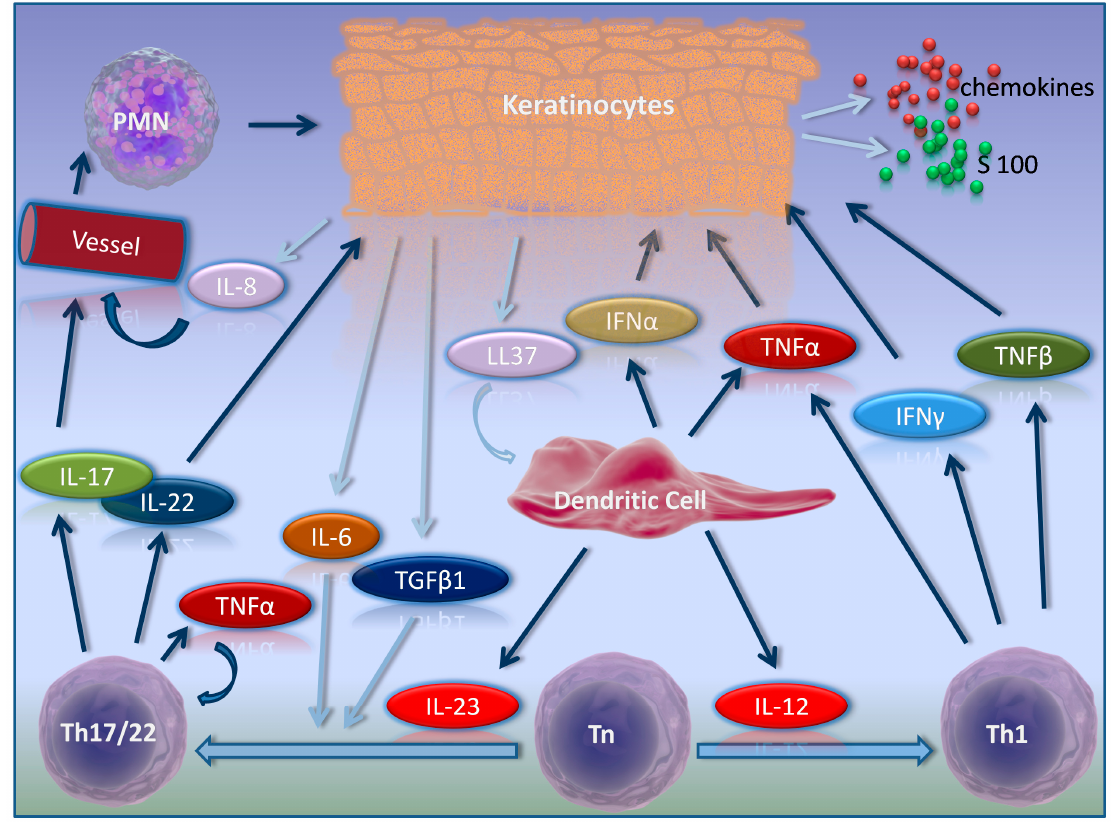
Figure 1. Cytokine network in psoriasis. IFN α = interferon- α , IFN γ = interferon- γ , IL-6 = interleukin-6, IL-8 = interleukin-8, IL-12 = interleukin-12, IL-17 = interleukin-17, IL-22 = interleukin-22, IL-23 = interleukin 23, LL37 = cathelicidin, PMN = polymorphonuclears, S 100 = S 100 proteins, Th1 = T helper 1, Th17 = T helper 17, Th22 = T helper 22, TGF β = transforming growth factor ‐ beta, Tn = naïve T lymphocyte, TNF α = tumor necrosis factor ‐α , and TNF β = tumor necrosis factor ‐β .